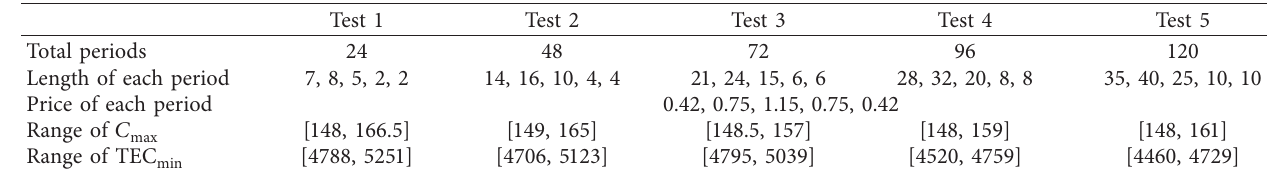
Table 7: Test results by different periods of TOU electricity tariffs.